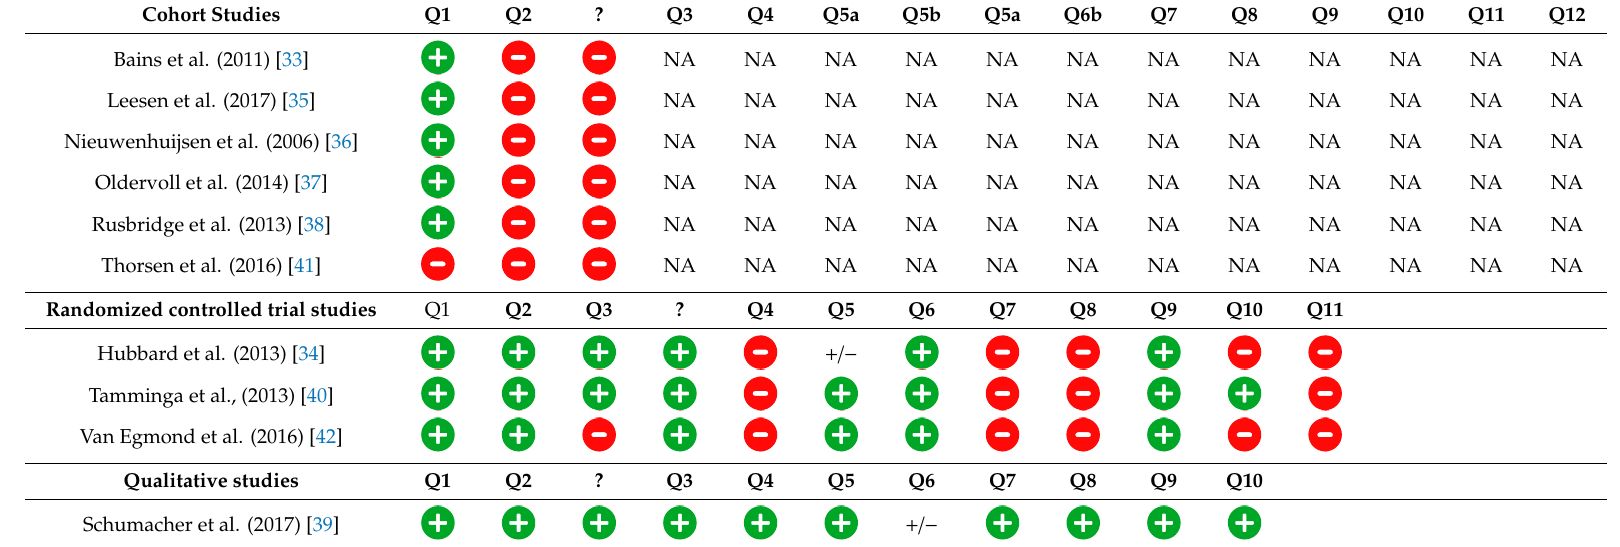
Table 2. The CASP checklists results for assessing the methodological quality of the included studies. Cohort Studies